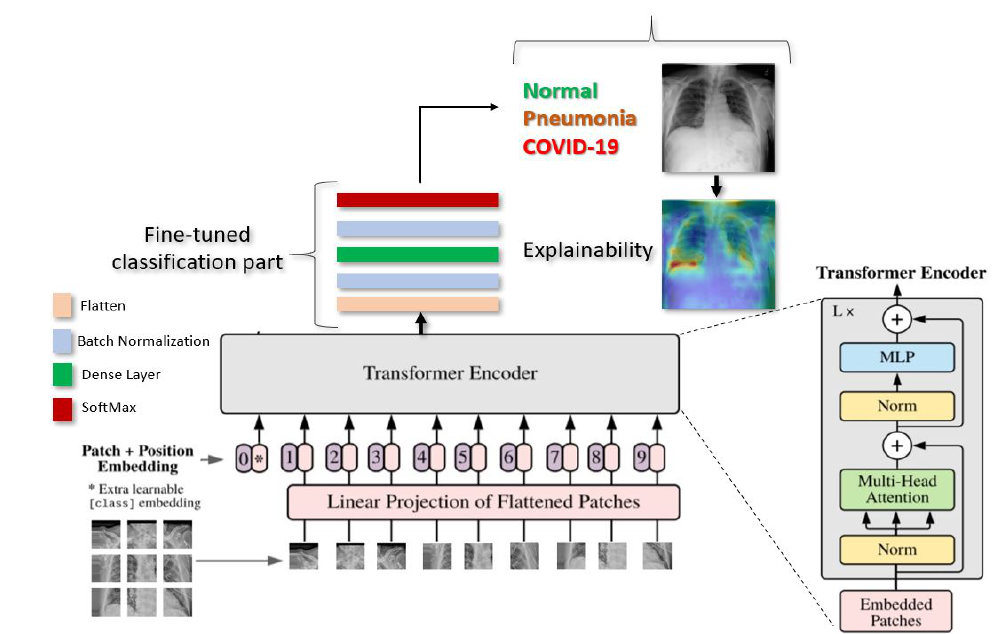
Figure 1. Illustration of our proposed ViT model for COVID-19 detection using CXR images. The in- put image is split into equal-sized patches and embedded using linear projection. Position embed- dings are added, and the resulting sequence is fed to a Transformer encoder.